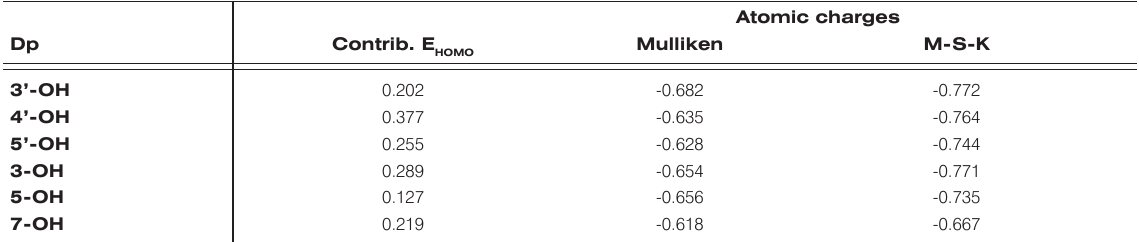
Table 6. Contributions to the E and atomic charges of the O atoms of the delphinidin hydroxyl groups (HF/6-31+G(2d,p) level). HOMO